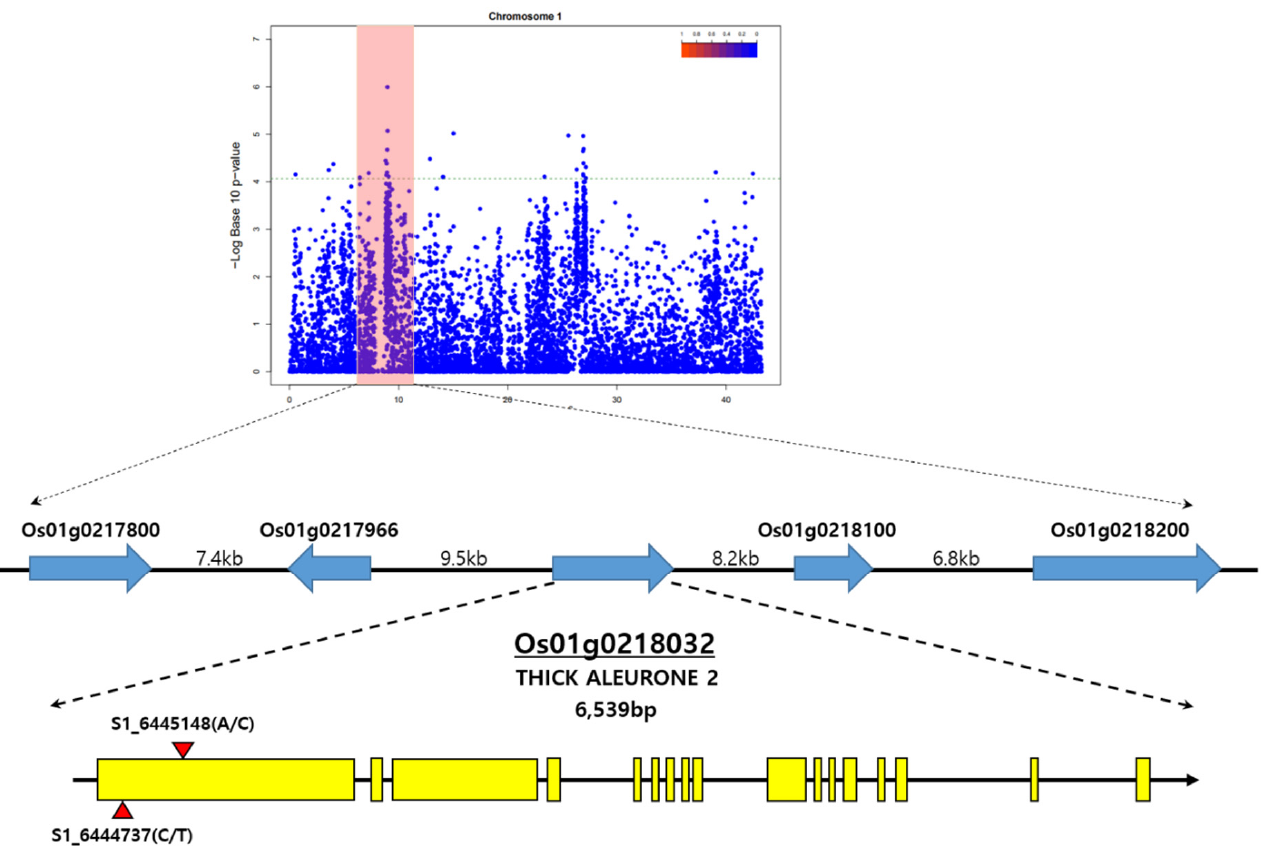
Figure 6. Manhattan plot derived from a GWAS scan for a traits of seed coat and aleurone layer thickness, thick aleurone 2 (TA2) gene structure, and its SNP location.